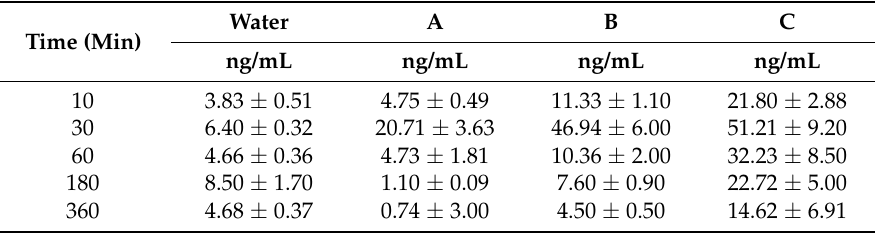
Table 3. Mean (mean ± DVST, n = 3) measured plasmatic concentrations of berberine after oral administration (50 mg/kg) in mice. Used eutectics are indicated with letters, namely, A: Proline Malic Acid 2:1, B: Proline Urea 2:1, C: Lactic Acid: Proline: Malic Acid: Water.